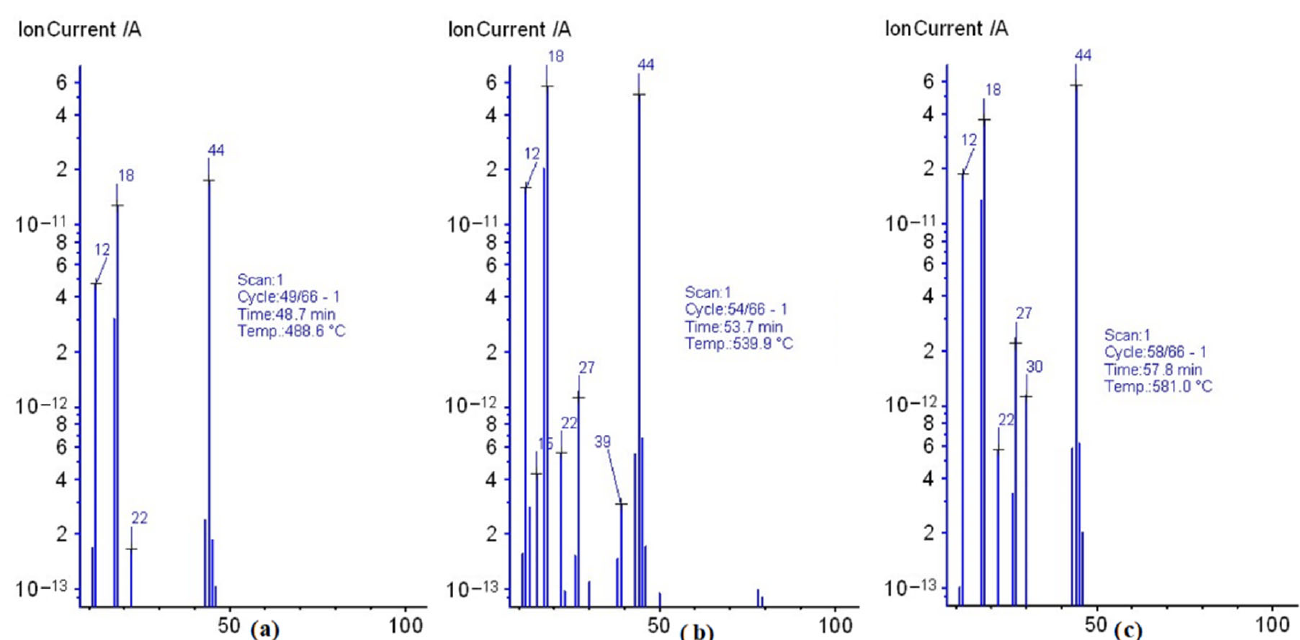
Figure 6. MS spectra for PEI-2 degradation in air at 489 ◦ C ( a ), 540 ◦ C ( b ), and 581 ◦ C ( c ). The FTIR spectra represented in Figure 7 were in full agreement with the MS results. The characteristic peaks were observed for water in the range 4000–3400 cm − 1 , for CO 2 in the range 2400–2200 cm − 1 , and for benzene in the range 1600–1400 cm − 1 . In the case of sam- ples containing Jeffamine segments, thermal decomposition in an inert atmosphere began at a temperature of approximately 400 ◦ C, with the fragmentation of the polypropyleneglycol- block and polyethyleneglycol-block (Scheme 2). The variation in the ionic current (Figure S11 Supplementary Materials) for the ionic fragments of PEI-1, PEI-3, and PEI-3-20% was found to be m/z = 58 (CH 3 CH 2 CHO + ), m/z = 73 (CH 3 CH 2 OCH 2 CH 3+ ), m/z = 15 (CH 3+ ), respectively, and m/z = 46 (C 2 H 5 OH + ) in the temperature range of 400–510 ◦ C. In the same temperature range, the variation in the ionic current also appeared for the fragments: m/z = 18 (H 2 O + ), m/z = 28 (CO + ), m/z = 44 (CO 2+ ), and m/z = 30 (CH 2 O + ), as presented in Figure S6. The decomposition of the bisphenol A group, the polyimide group, and the 1,3-phenylenedioxy group began at temperatures higher than 510 ◦ C. Figure S7 shows the variation in the ionic current for some of the ionic fragments resulting from their decom- position, respectively, m/z = 78 (C 6 H 5+ ), m/z = 91 (C 7 H 7+ ), m/z = 94 (C 6 H 5 OH + ), and m/z = 108 (HOC 6 H 4 OH + ). As can be seen from Figure S7, the fragment m/z = 94 was not present in the case of PEI-3-20%, and the fragment m/z = 108 in the case of PEI-1. In the case of PEI-3-20%, due to the presence of oxygen in a larger amount, a higher intensity of the peaks corresponding to the fragment m/z = 18 (H 2 O + ) and fragment m/z = 44 (CO 2+ ) (Figure S6 Supplementary Materials) was found. The lack of ion current variation for the m/z = 108 fragment in the case of PEI-1 was related to the fact that it does not contain the 1,3-phenylenedioxy group. According to Figure S8 from the Supplementary Materials, the presence of the fragment m/z = 103 (C 6 H 5 CN + ) was highlighted in the case of all samples, which can also result in the ionic fragment m/z = 44 (CO 2+ ) (Figure S6) and the fragment m/z = 28 (CO + ) (Figure S6) from the degradation of the polyimide group